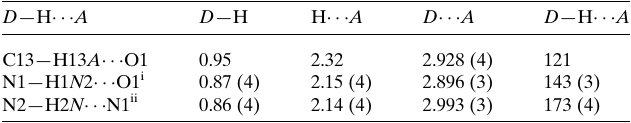
Table 1 Hydrogen-bond geometry (A˚ , (cid:2) ).